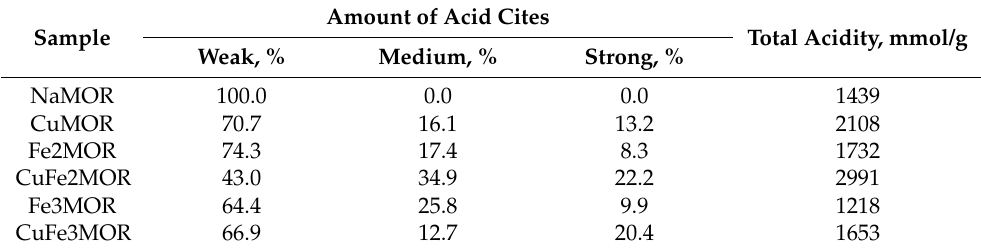
Table 4. Acidity by TPD NH 3